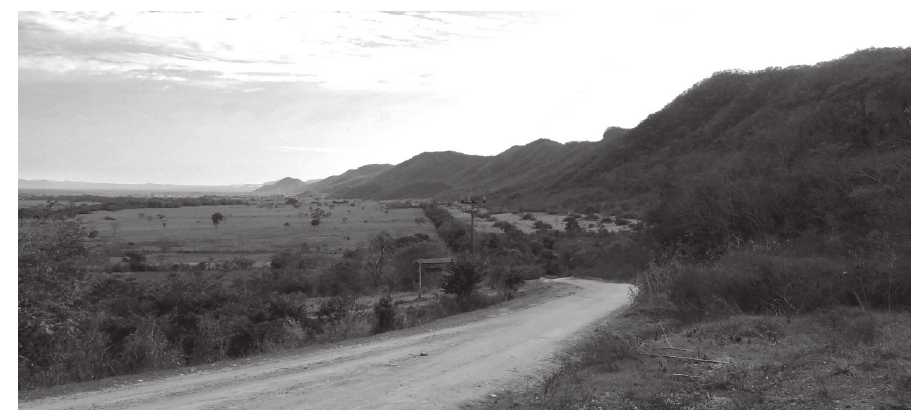
Figure 5 - A series of hills aligned according to the NS direction. The picture was taken from the Bodoquena Belt looking